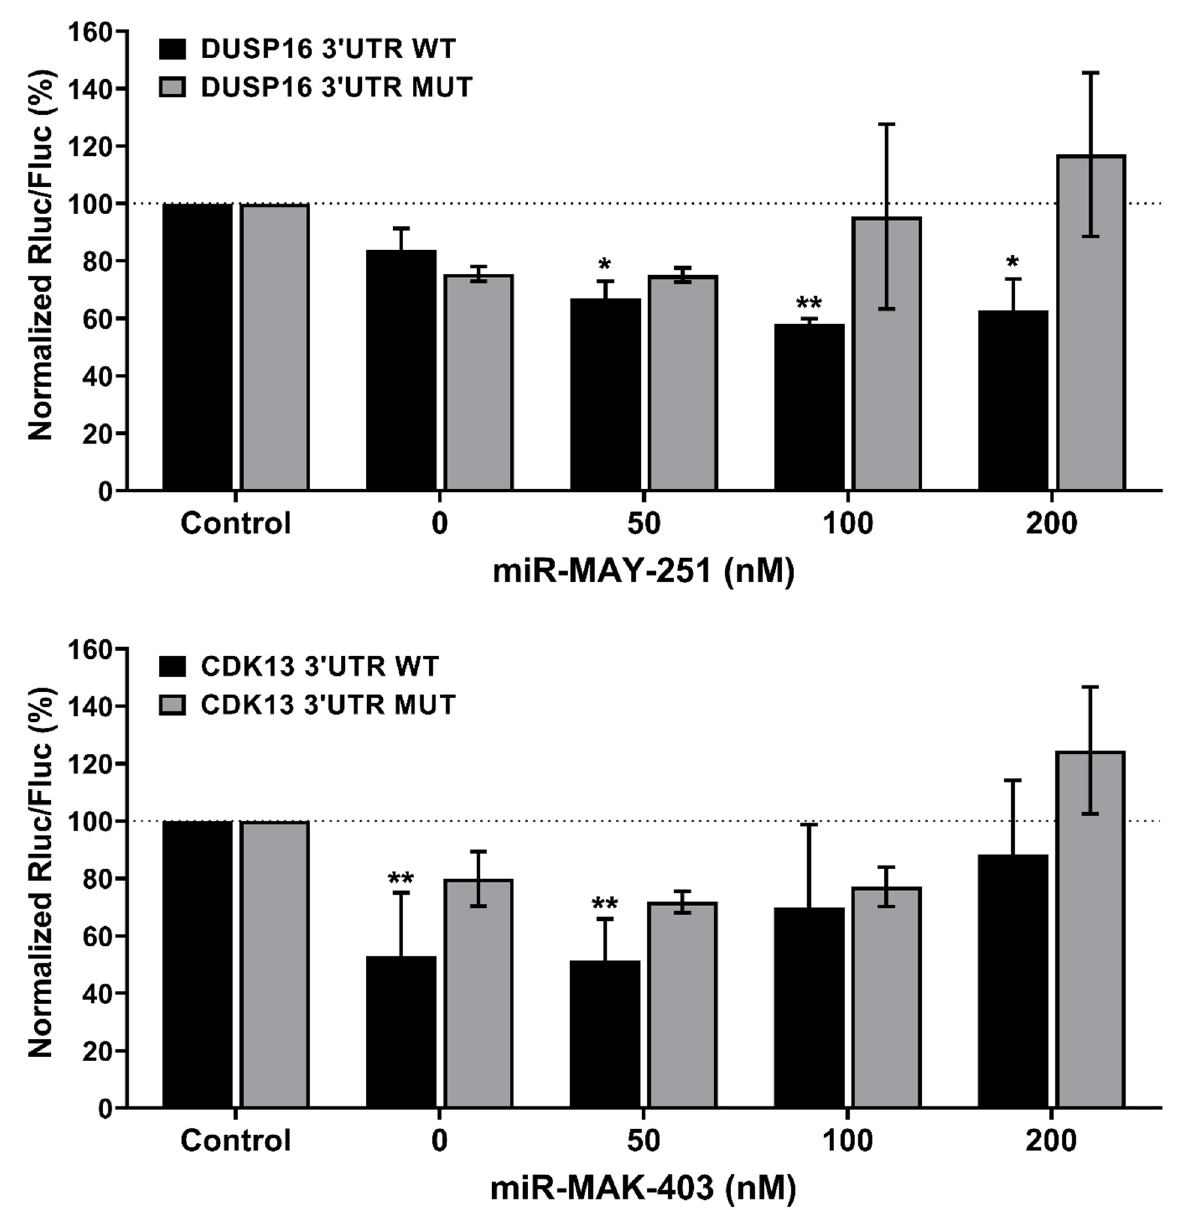
Figure 7. Modulation of human host mRNA target by EBOV microRNAs through their 3 ′ UTRs. Huh7 cells were co-transfected with EBOV miR-MAY-251 (upper panel) or miR-MAK-403 (l ower panel ) mimic (0, 50, 100, and 200 nM) and a psiCHECKII reporter construct (50 ng; see Supplemen- tary File S3), in which the Rluc reporter gene was coupled with wild-type (WT) or mutated (MUT) DUSP16 ( upper panel ) or CDK13 ( lower panel ) 3 ′ UTR. An unrelated, negative RNA control (Con- trol) was used for normalization, in addition to the internal normalizer Fluc. “0 nM” corresponds to the transfection reagent-only control. Statistical analysis: Data were calculated from three biological replicates and expressed as means ± SD. The two-way analysis of variance (ANOVA) and Dunnett’s multiple comparisons test were used, and statistically significant differences (fold change vs. mock) are indicated as follows: * p < 0.05; ** p < 0.01 .